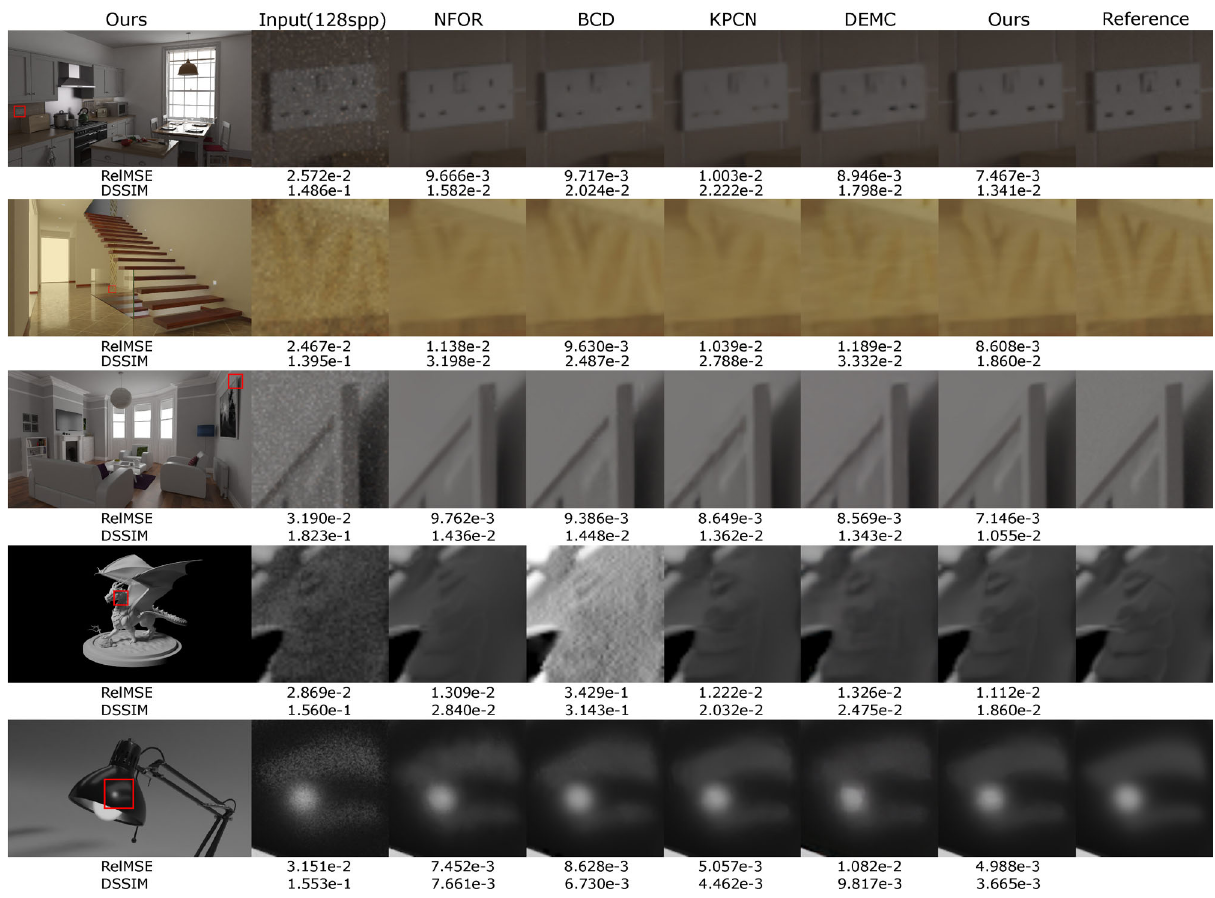
Fig. 6 Comparison of our method to four other state-of-the-art methods NFOR [15], KPCN [2], BCD [17], DEMC [8], and reference images. KPCN’s input features and loss function are as in the original paper (Section 3.2). Our model includes light transport covariance, besides the features of KPCN, and is trained with the loss function in Section 4.3. KPCN, DEMC, and our model have identical other training settings (see Section 5.2) and used the same dataset for